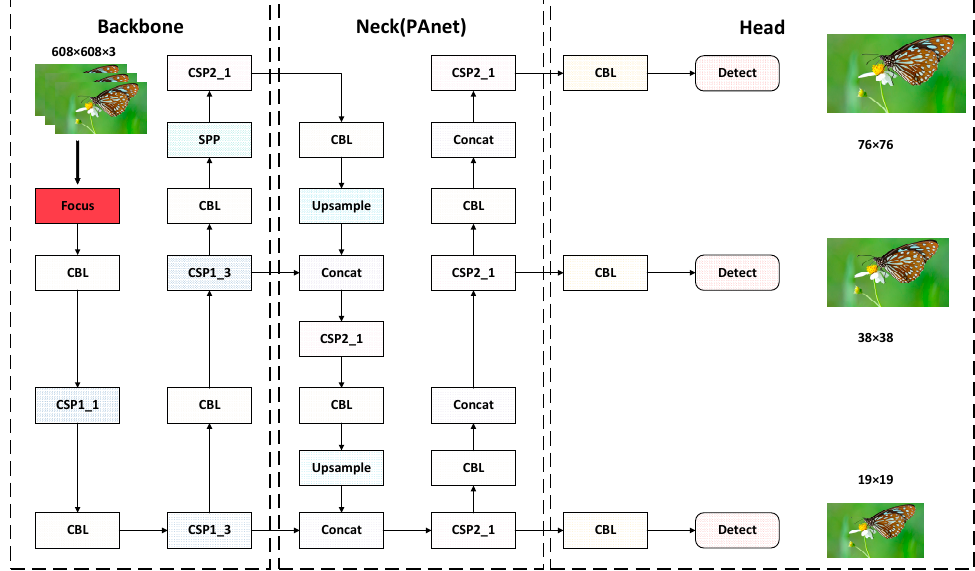
Figure 1. YOLOv5s network structure.